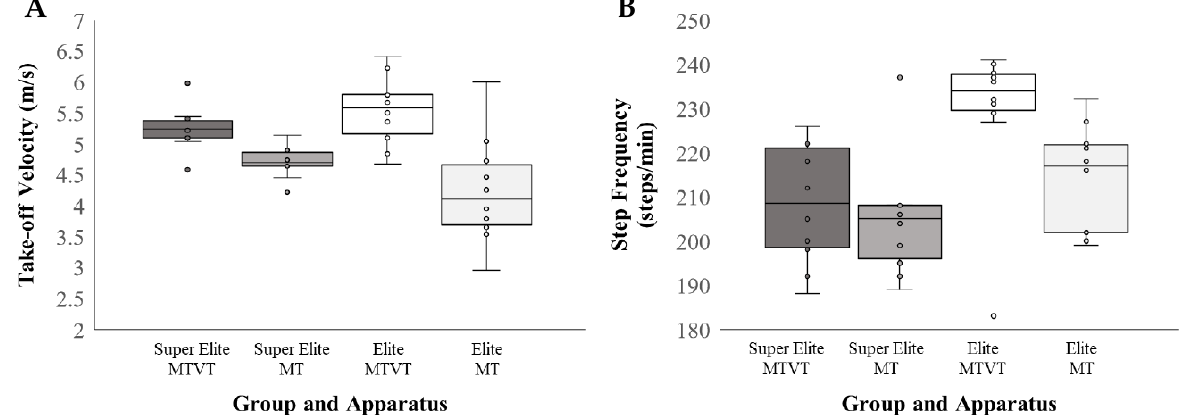
Figure 4. Kinematic measures by group (super elite vs. elite) and apparatus (MTVT vs. MT): ( A ): take-off velocity in meters per seconds; ( B ) step frequency in steps per minute.